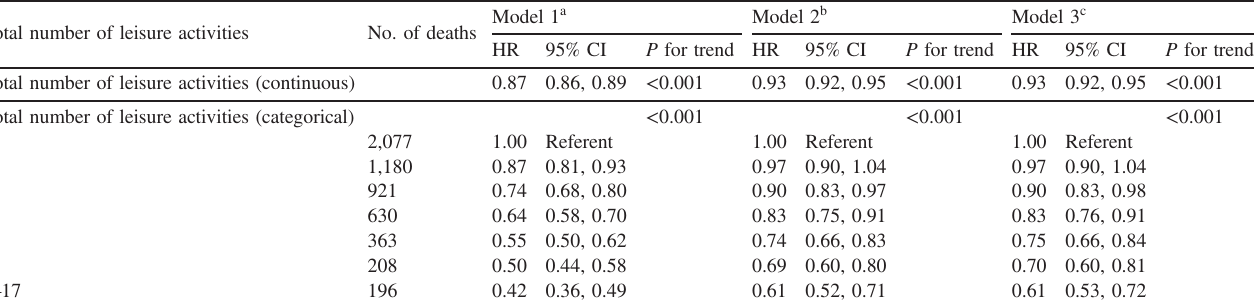
Table 2. Association of the total number of leisure activities with all-cause mortality in older Japanese adults ( n = 48,216), Japan, 2010 –